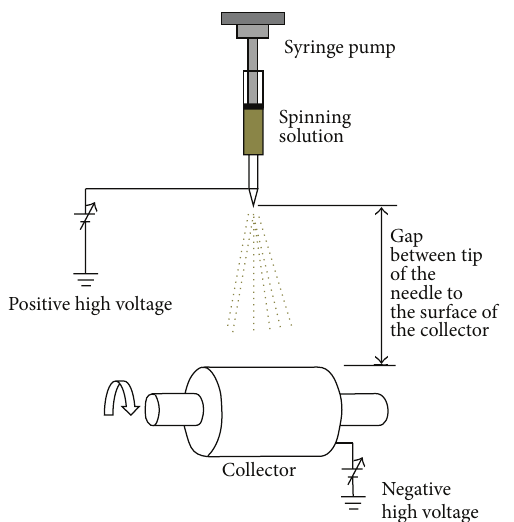
Figure 11: A basic electrospinning setup